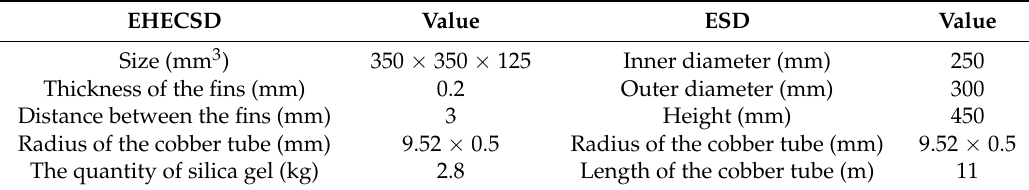
Figure 17. The FFASHP water heater system combined with solid desiccant and energy storage [52]. Table 10. The structural parameters of extra heat exchanger coated by a solid desiccant with an energy storage device (EHECSD) and energy storage device (ESD) [10].